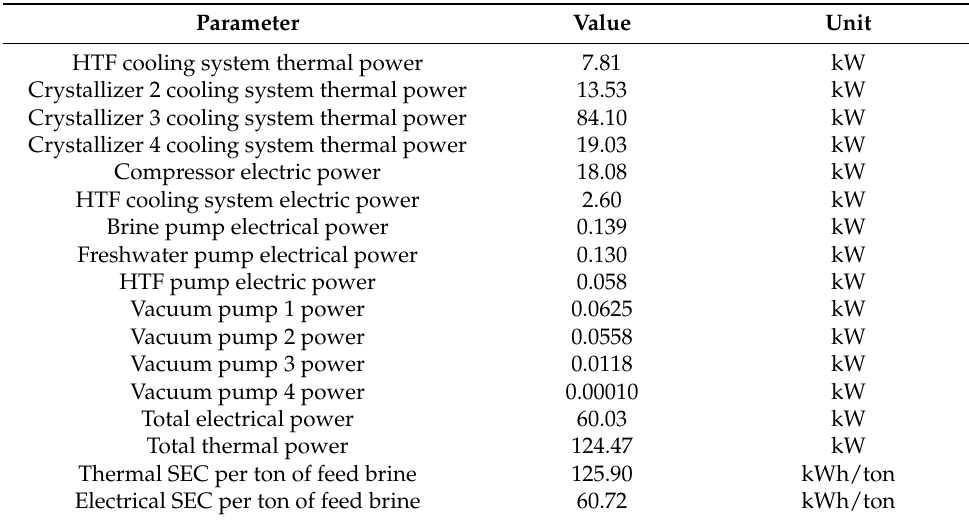
Table 10. Energy consumption results for the multi-crystallization system for 1000 kg/h of feed brine.